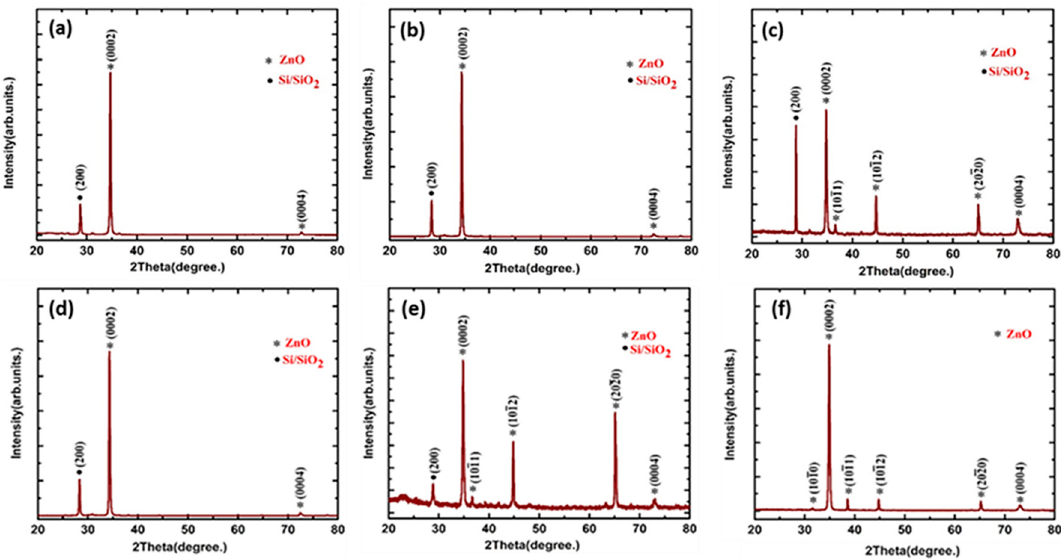
Figure 2. XRD spectrum of VAZO nanorods grown on Si substrate at ( a ) 500 °C, ( b ) 550 °C, ( c ) 600 °C and XRD spectrum of VAZO nanorods grown on Si substrate at 550 °C by varying the number of shots ( d ) 5000, ( e ) 10,000, ( f ) 15,000.